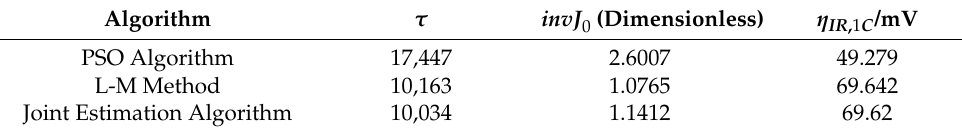
Figure 6. Current profile of the CITY operating condition test. Table 2. Model parameter identification results of three types of algorithm. Table 2. Model parameter identification results of three types of